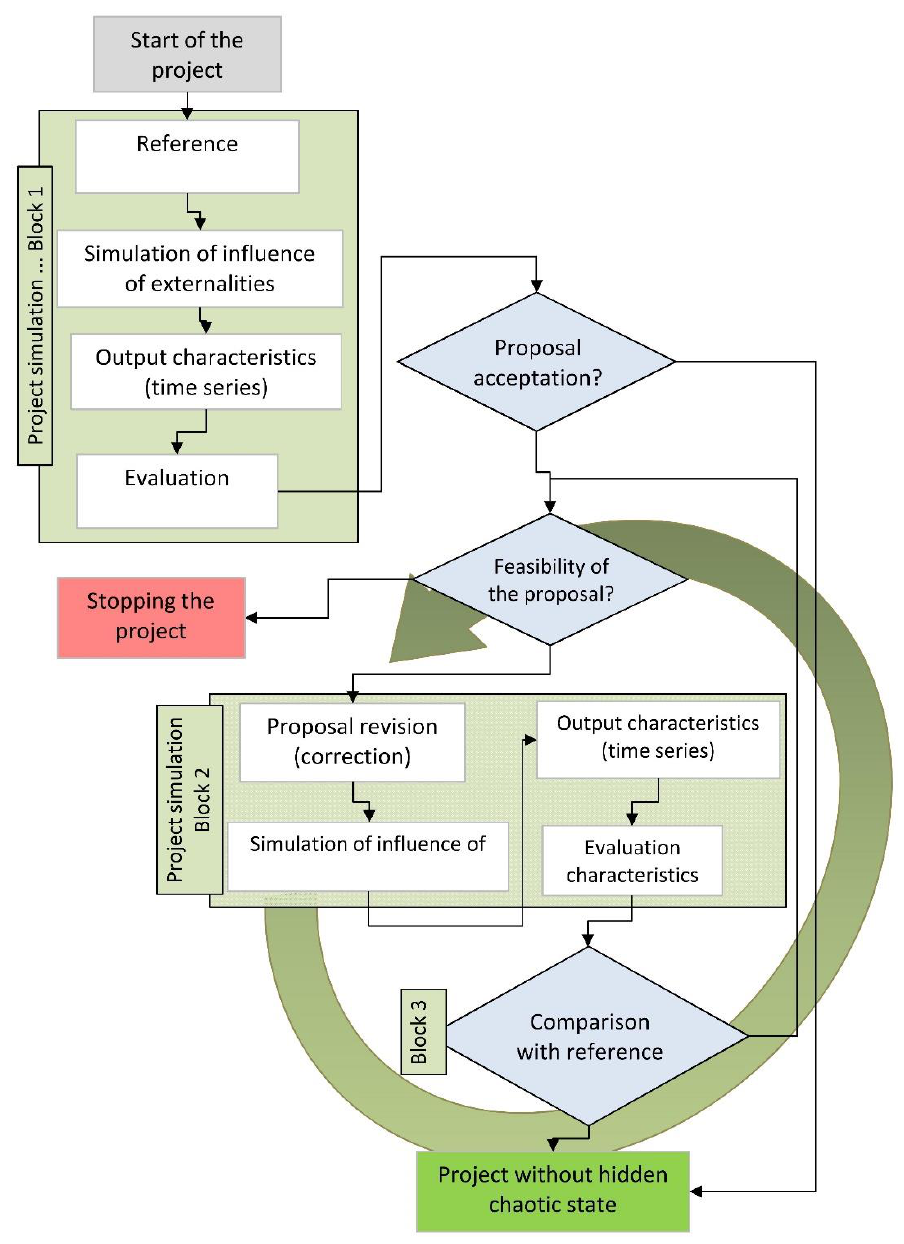
Figure 10. The simulation circle flowchart. Source: authors.